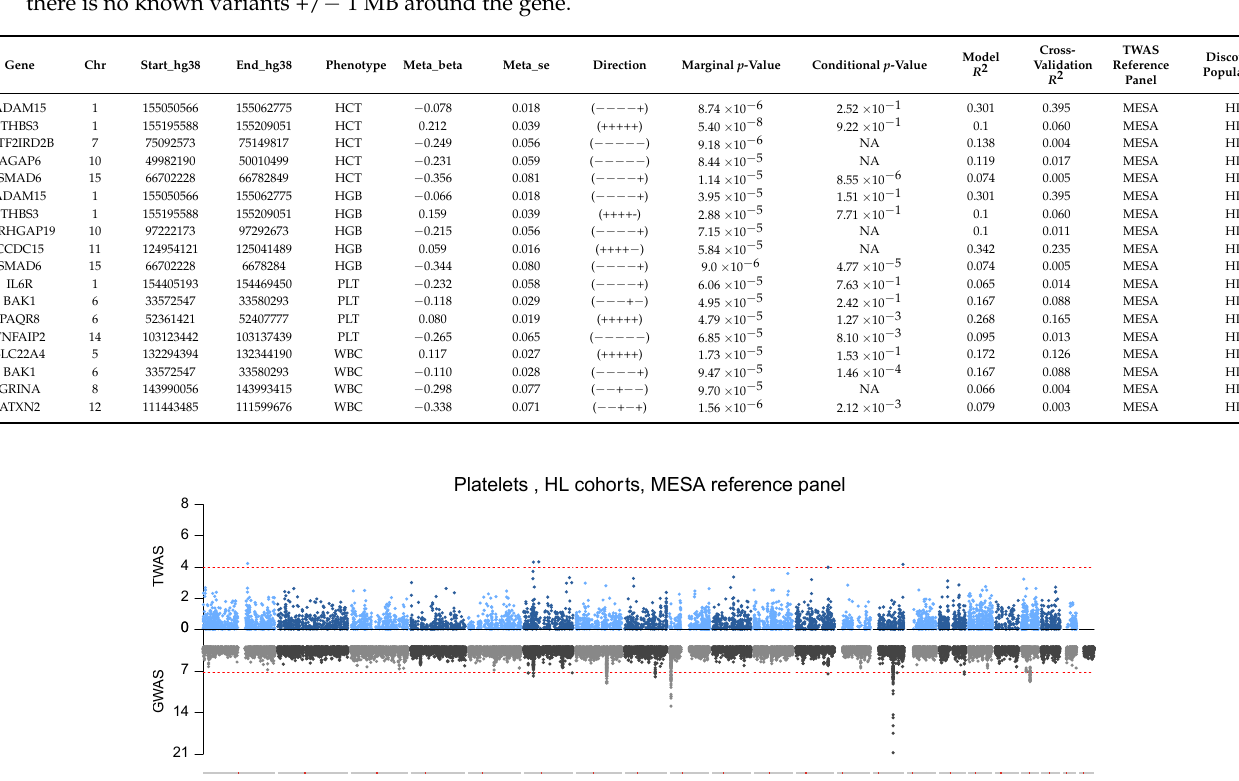
Table 1. The table shows the marginally significant results discovered by MESA HL for all four phenotypes. “NA” denotes there is no known variants +/ − 1 MB around the gene.